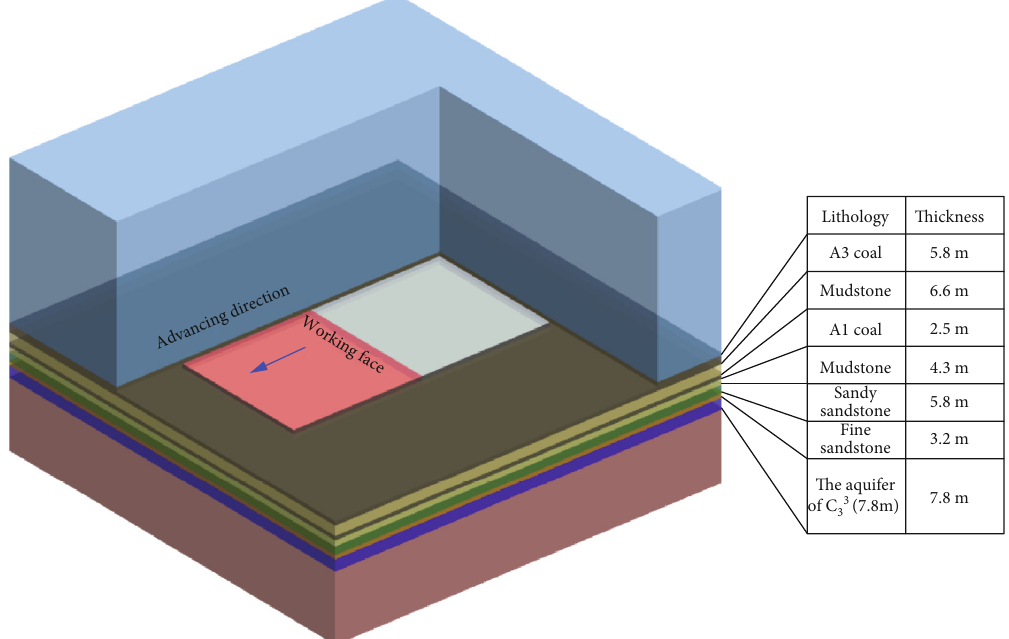
Figure 2: Working face arrangement and lithologic